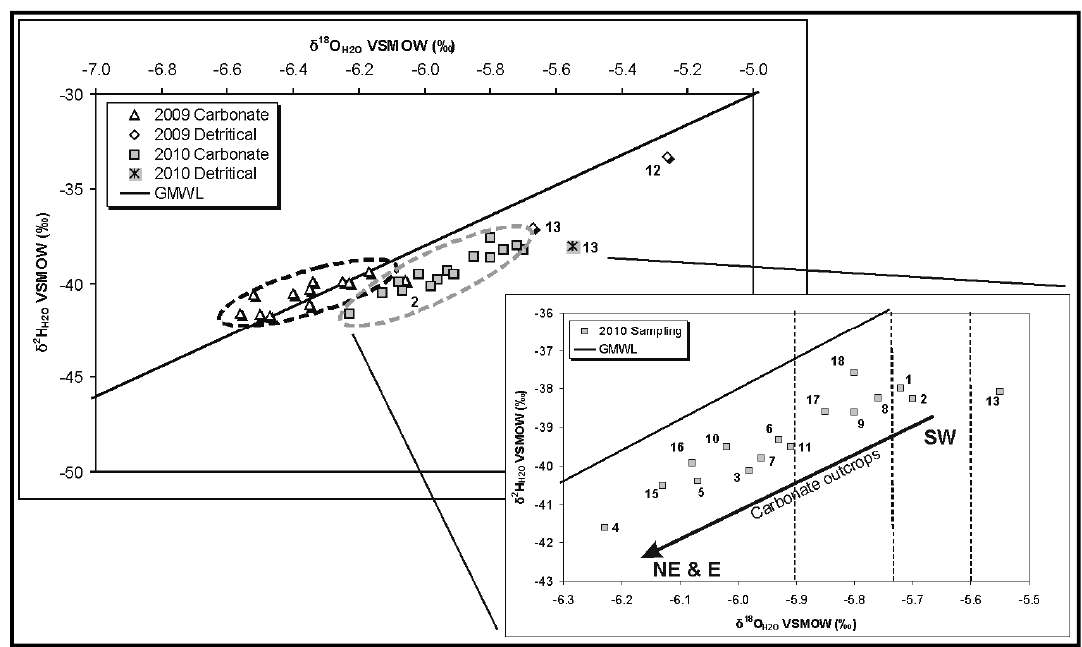
Figure 6. Isotopic results differentiated by field campaign and materials on which sampling points are located, with expansion in the 2010 sampling values (global meteoric water line (GMWL)).